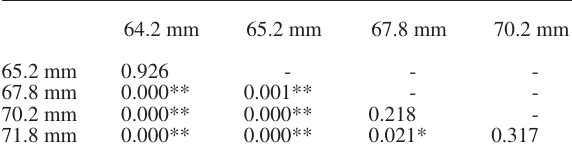
Table 4. – P-values of Mann-Whitney U-test applied to the Total Lengths of soles caught with the different mesh sizes. ** = highly significant; * = significant.